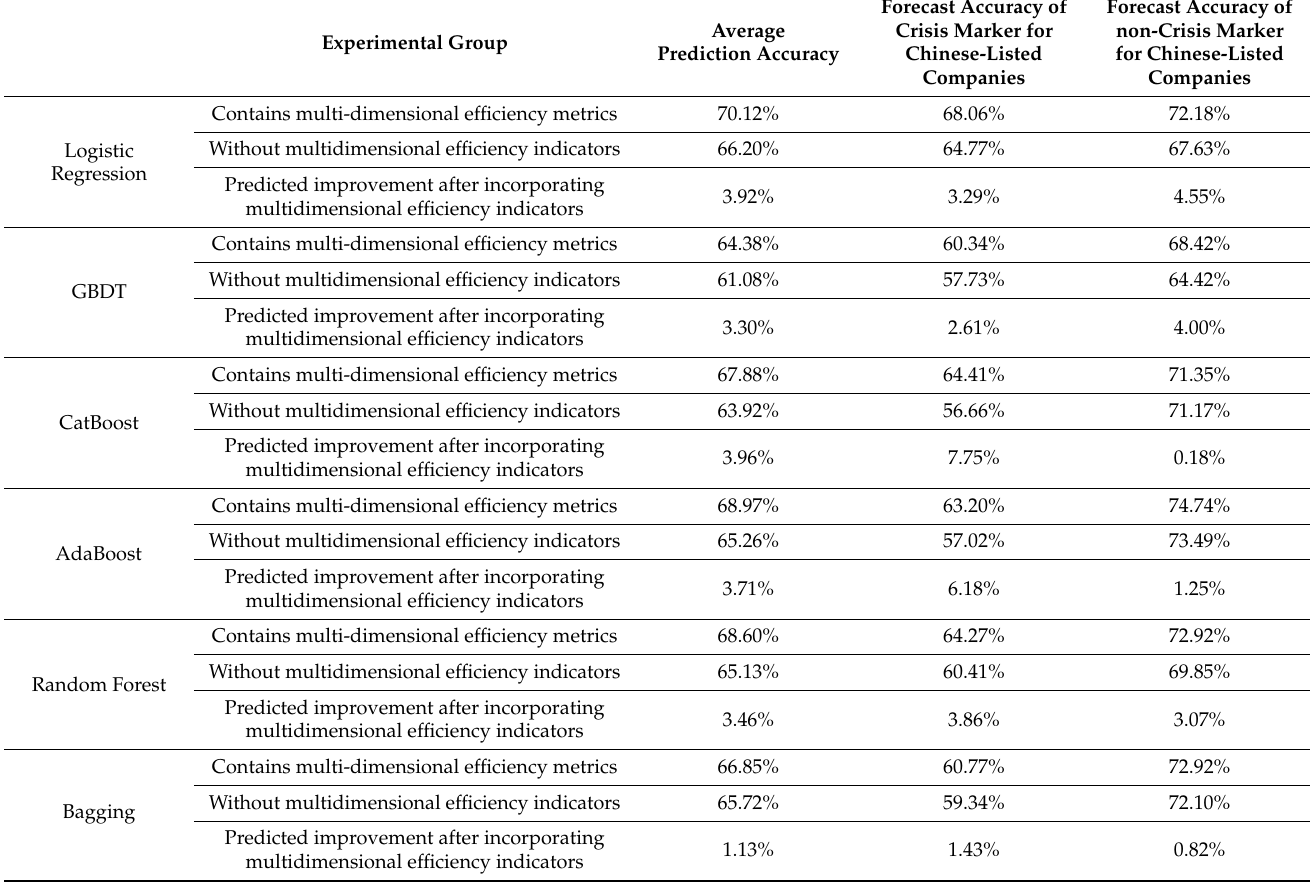
Table 13. Results on the prediction accuracy of other machine learning models.